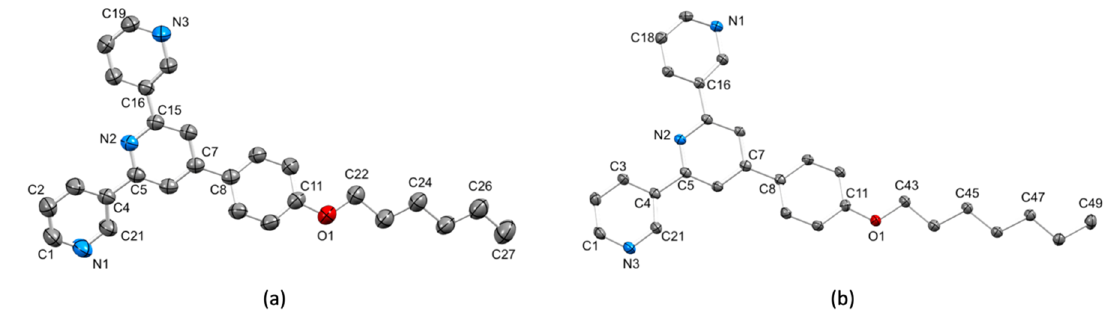
Figure 2. ORTEP representations of one of the two independent molecules of ( a ) 6 and ( b ) 7 (ellipsoids are plotted at a 40% probability level, and H atoms are omitted for clarity). For 6 : C11–O1 = 1.3612(19) Å, C22–O1 = 1.406(2) Å, C11–O1–C22 = 120.10(14)° and for the second independent molecule, the corresponding values are 1.3607(17) Å, 1.4254(18) Å, and 119.30(12)°. For 7 : C11–O1 = 1.3574(19) Å, C43–O1 = 1.4345(18) Å, C11–O1–C43 = 118.51(12) ◦ and for the second independent molecule, the